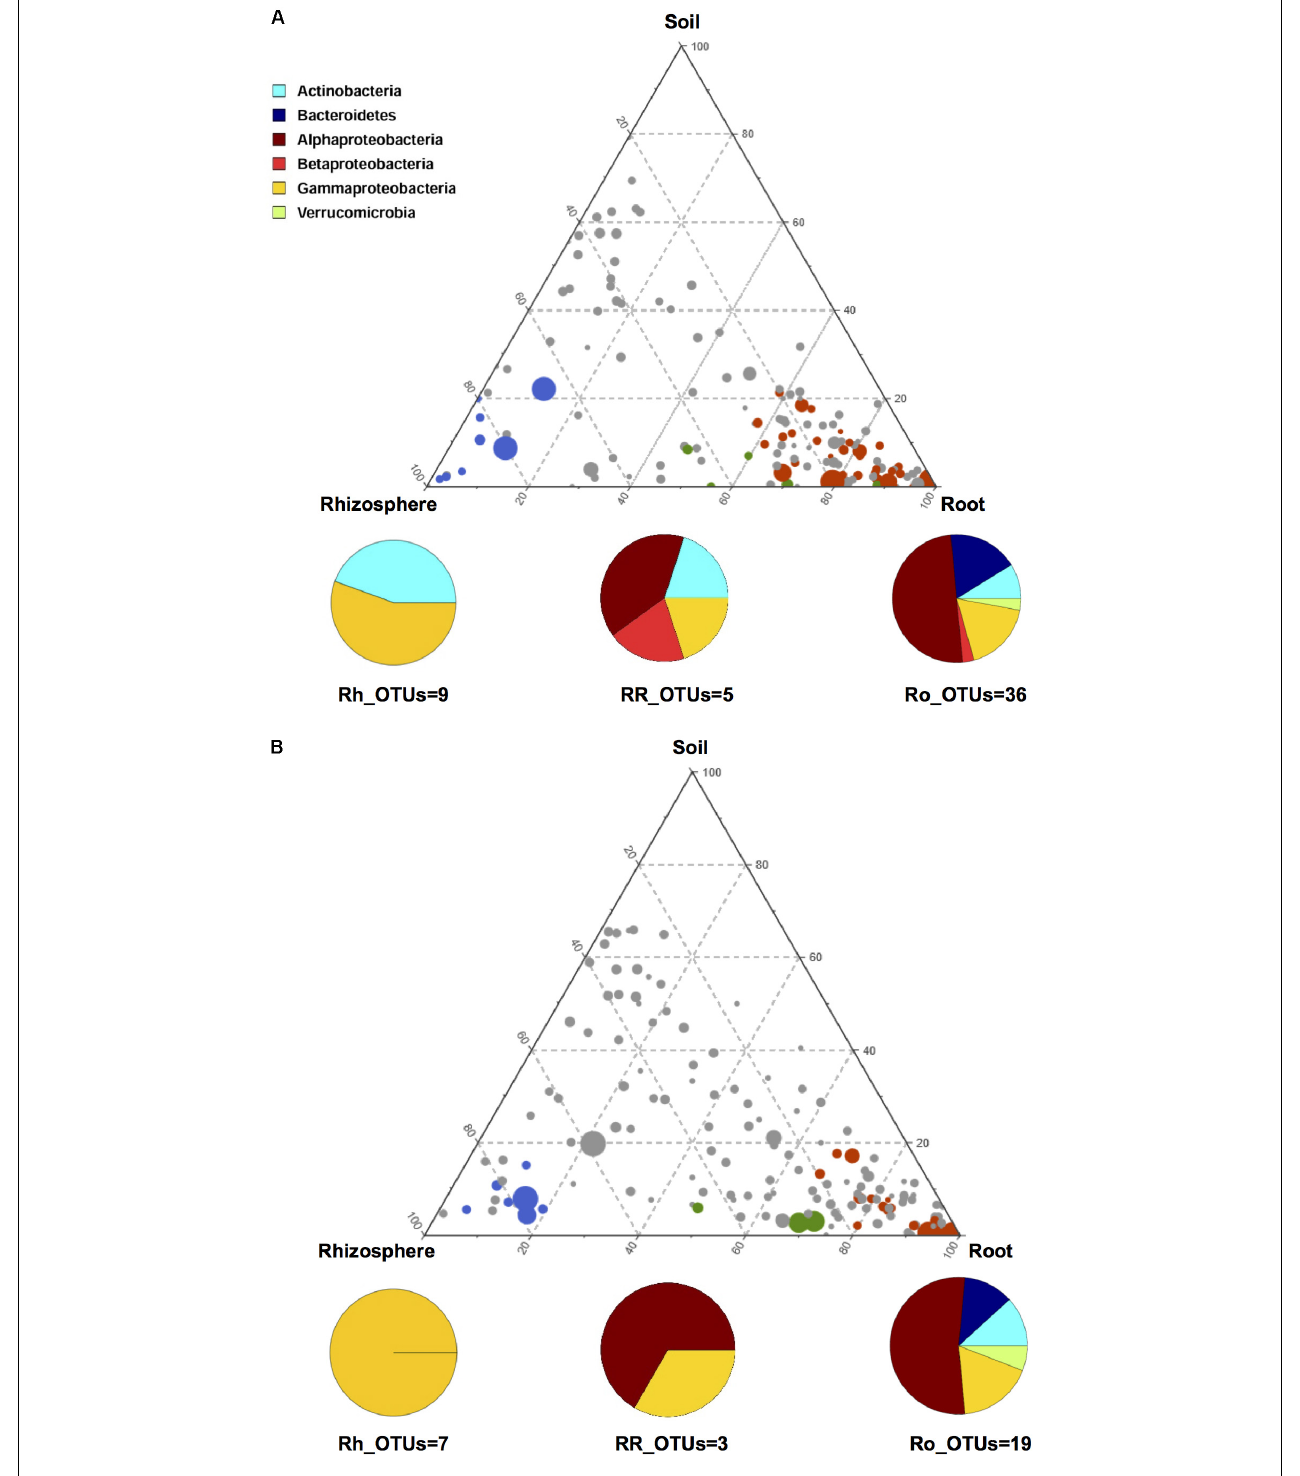
FIGURE 4 | OTU enrichment at the root-soil interface for V. vinifera cultivar Lambrusco grafted onto different rootstocks. Ternary plots of all OTUs detected in the dataset with relative abundance > 0.5% in at least one sample, in V. vinifera 5BB (A) and V. vinifera 1103P (B) . Each circle represents one OTU, and the size is proportional to the weighted relative abundance. Red circles indicate OTUs significantly enriched in the root microhabitat (Ro_OTUs), blue circles indicate OTUs significantly enriched in the rhizosphere microhabitat (Rh_OTUs) and green circles indicate OTUs significantly enriched in both root and rhizosphere microhabitats (RR_OTUs). Mann-Whitney-Wilcoxon test, FDR-adjustment, P < 0.05. See also Supplementary Table S2 .